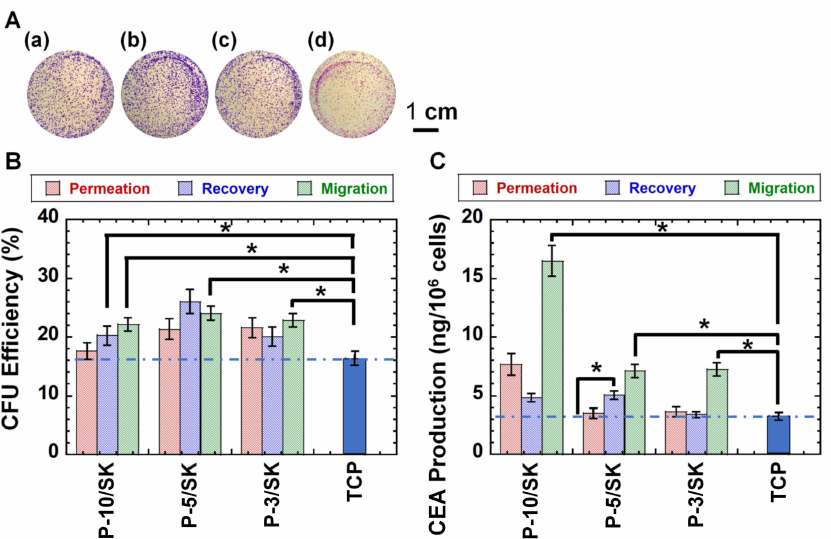
Figure 5. Colony-forming unit analysis and CEA production of colon carcinoma HT-29 cells after filtration via the NM-11 and PLGA/SK filters. ( A ) Colony-forming photos of colon carcinoma HT-29 cells in the permeation solution ( a ), recovered solution ( b ), and migrated cells ( c ) through the PLGA-10/SK filters. The colony-forming photo of the cells cultivated on TCP plates is also described (control) ( d ). The bar indicates 1 cm. ( B ) The number of colony-forming colon carcinoma HT-29 cells in the permeation solution and recovered solution and the cells that migrated through the PLGA-10/SK (P-10/SK), PLGA-5/SK (P-5/SK), and PLGA-3/SK (P-3/SK) filters as well as the number of colony-forming colon carcinoma HT-29 cells that were cultured on TCP dishes (control). ( C ) CEA production of colon carcinoma HT-29 cells in the permeation solution and recovered solution and the cells migrated through the PLGA-10/SK (P-10/SK), PLGA-5/SK (P-5/SK), and PLGA-3/SK (P-3/SK) filters as well as CEA production of colon carcinoma HT-29 cells, which were cultured on TCP dishes (control). * p <